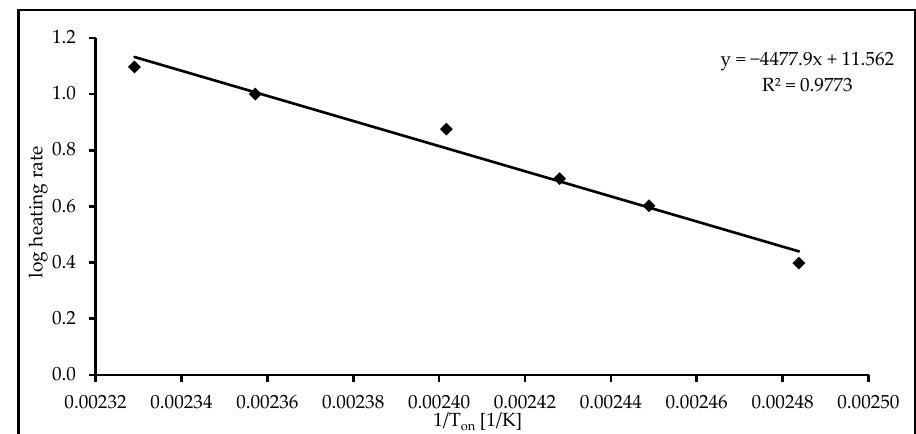
Figure 4. Temperature shift at the onset (of the oxidation process) of DSC curves depending on the logarithm of heating rate of the thermo ‐ oxidative decomposition of silverskin fat.